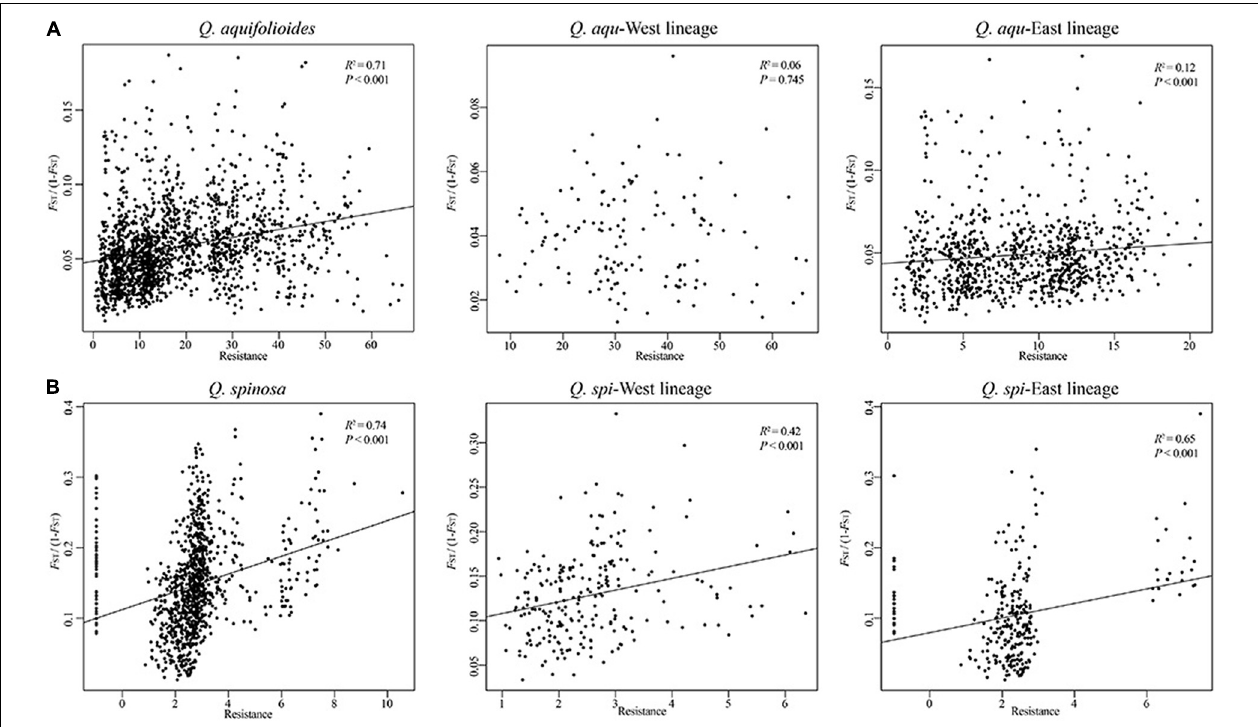
FIGURE 5 | Relationship of genetic distance ( F ST / (1- F ST )) and resistance distance based on climatic niche suitability of (A) Q. aquifolioides and (B) Q. spinosa .